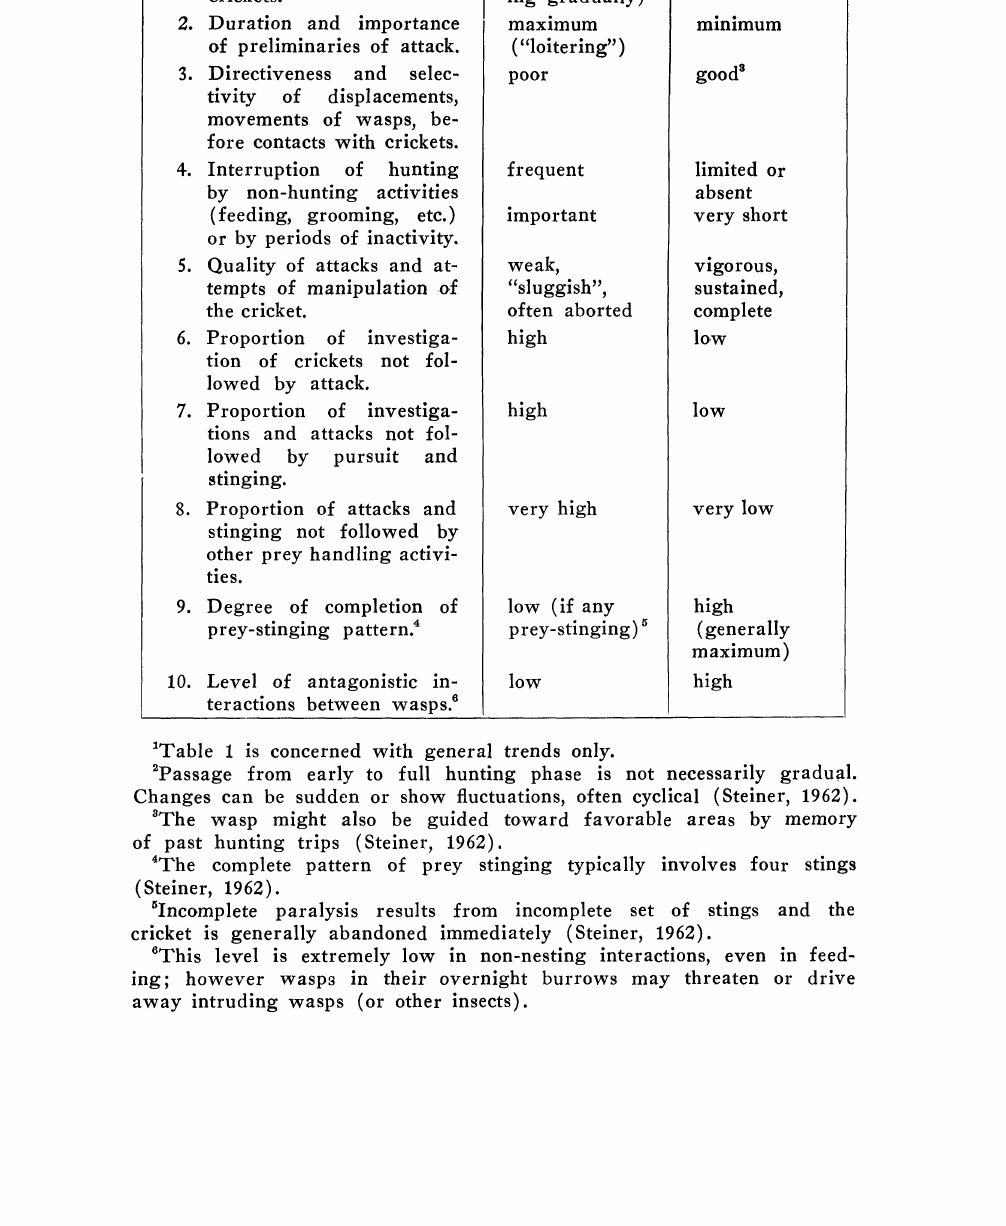
Table 1. Typical changes from onset to completion of hunting phase, Different parameters